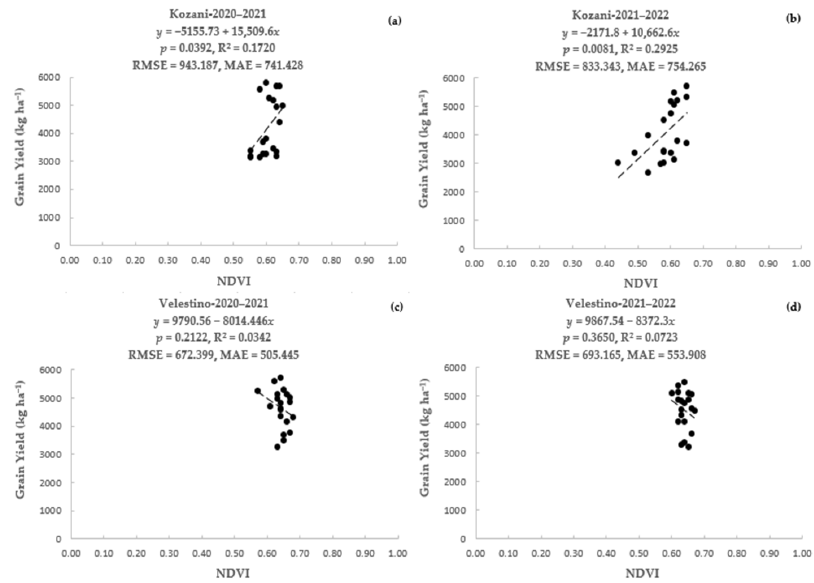
Figure 6. Linear regression between grain yield ( y ; kg ha − 1 ) and crop NDVI ( x ) in ( a ) Kozani ‐ 2020– 2021 (intercept SE: 4220.57; slope SE: 6973.19), ( b ) Kozani ‐ 2021–2022 (intercept SE: 2104.22; slope SE: 3582.82), ( c ) Velestino ‐ 2020–2021 (intercept SE: 3984.09; slope SE: 6196.51), and ( d ) Velestino ‐ 2021– 2022 (intercept SE: 5749.82; slope SE: 9008,99). Model DF: 1; Residual DF: 18; Total DF: 19; DF: Degrees of Freedom; SE: Standard Error; RMSE: Root Mean Square Error; MAE: Mean Absolute Error; R 2 : Coefficient of Determination (adjusted for